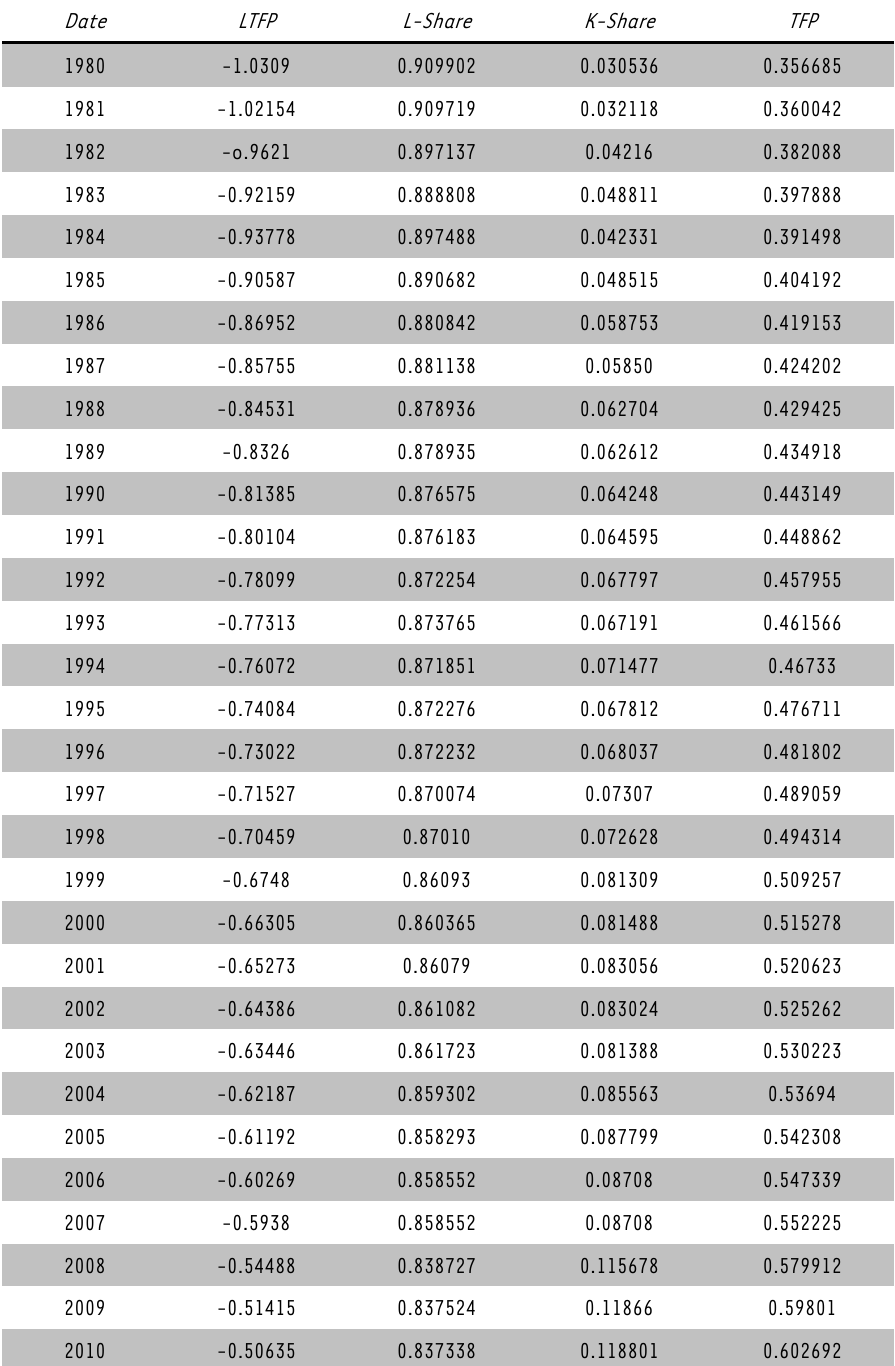
TABLE 3: Estimates of TFP, Labour and Capital Shares